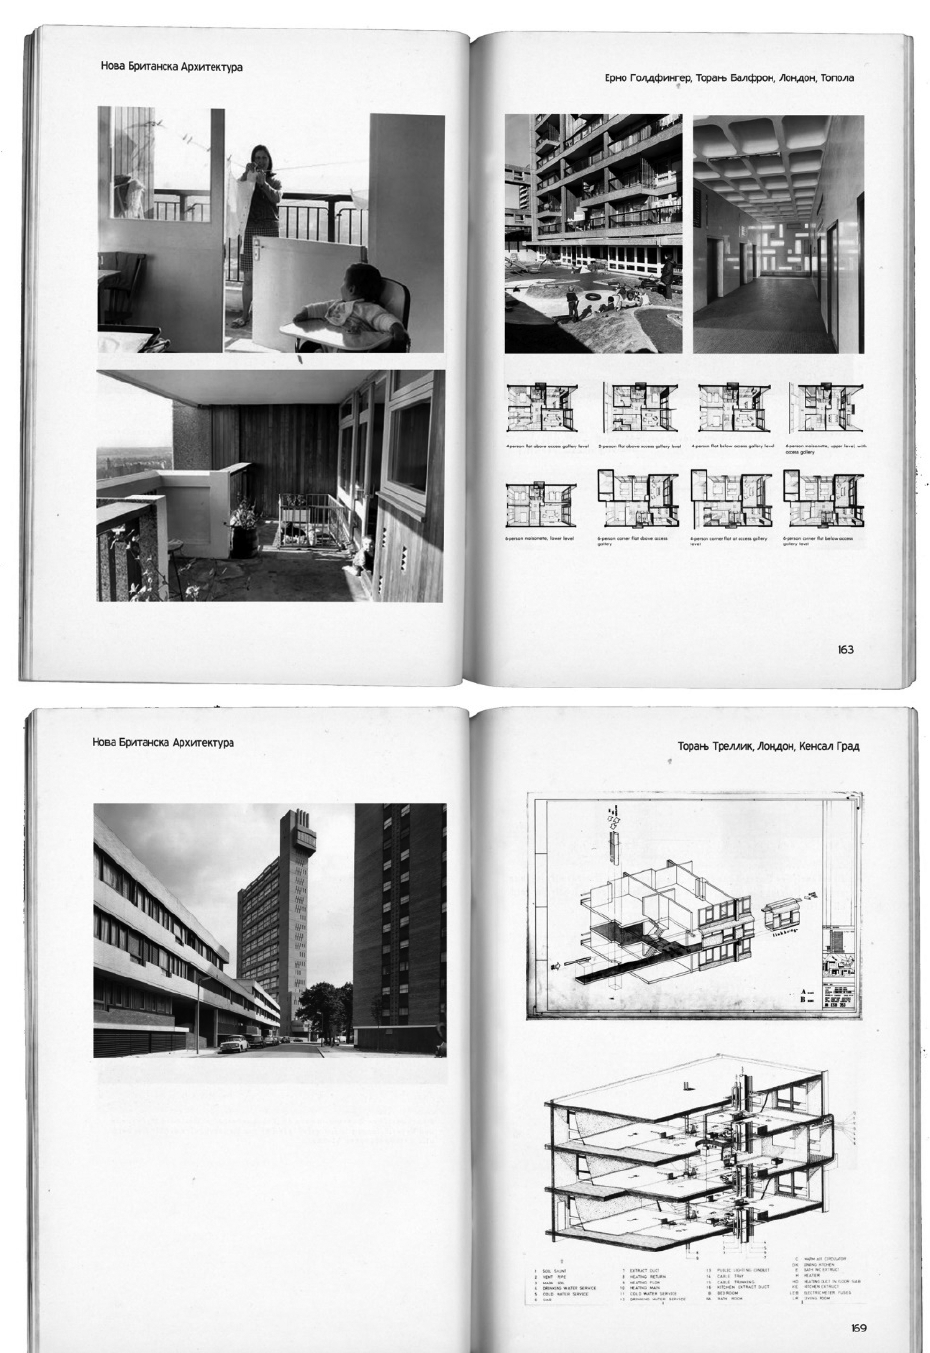
Figure 8. Georgi P. (1979), Nova Britanska Arhitektura , Architektonska Edizia, Novoselo.